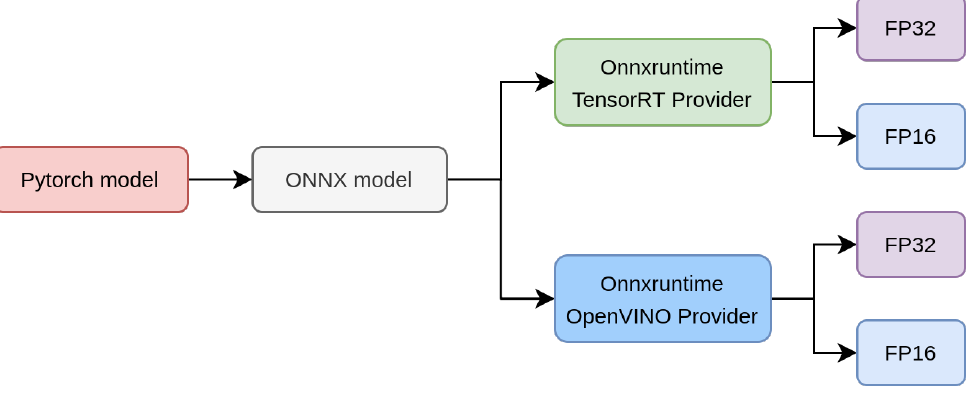
Figure 5. Crowd-counting model conversion pipeline.